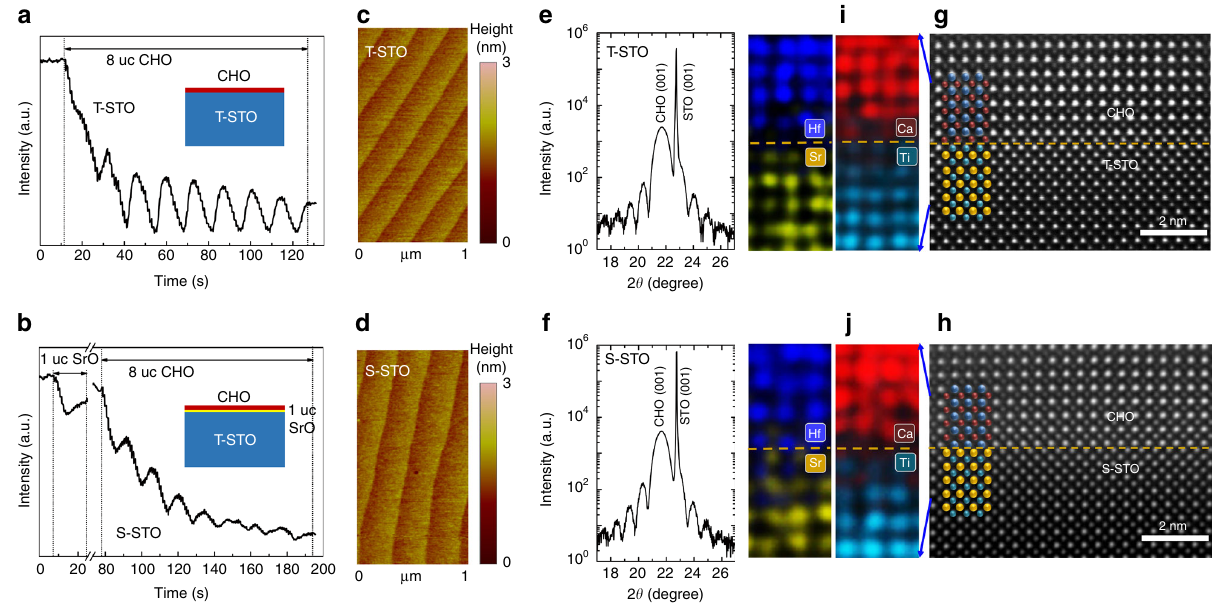
Fig. 1 Growth and structural characterizations of two types of interfaces between CaHfO 3 (CHO) and SrTiO 3 (STO). a , b Re fl ection high-energy electron diffraction (RHEED) intensity oscillations of the specular re fl ected beam for the growth of CHO directly on TiO 2 -terminated STO (T-STO), and after a monolayer of SrO was deposited on the T-STO, namely SrO-terminated STO (S-STO), respectively. Insets show the schematics of the two structures. c , d Atomic force microscopy (AFM) surface morphologies of 8 uc CHO grown on T-STO and S-STO, respectively. The size of both images is 1 μ m × 2 μ m. e , f X-ray diffraction (XRD) fi nite-thickness oscillations in the vicinity of the (001) re fl ection for 20 uc CHO grown on T-STO and S-STO, respectively. g , h Cross-sectional scanning transmission electron microscopy (STEM) images of 8 uc CHO grown on T-STO and S-STO, respectively. i , j The energy- dispersive X-ray spectroscopy (EDS) elemental mapping of the same samples from g , h ,